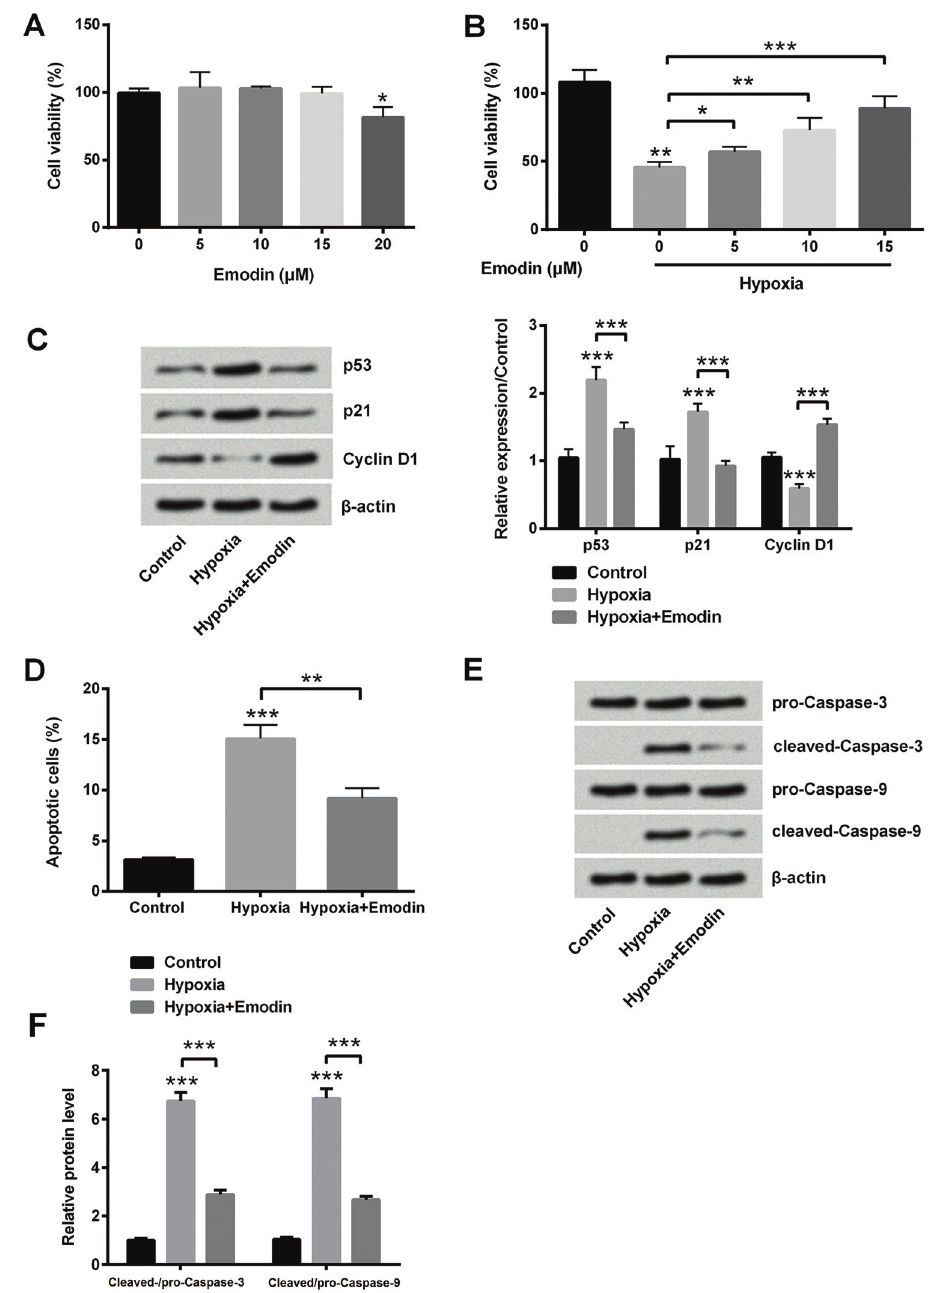
Figure 2. The appropriate concentration of emodin reduced the damaging effect of oxygen-deprivation on H9c2 cells. A , Emodin with concentration less than 20 m M had no inhibitory effect on viability of H9c2 cells detected by CCK-8 assay. B , Emodin promoted viability of oxygen-deprived H9c2 cells in a dose-dependent manner detected by CCK-8 assay. Emodin treatment ( C ) increased the pro-proliferation protein expression and decreased the anti-proliferation protein, ( D ) declined apoptotic cell rate, and ( E – F ) inhibited the pro-apoptosis protein expression. The expression of protein level was detected by western blot and cell apoptosis was measured by fl ow cytometry. Data are reported as means ± SD of triplicates. Each experiment was performed three times. *P o 0.05, **P o 0.01, ***P o 0.001 compared to control or as indicated (one-way analysis of